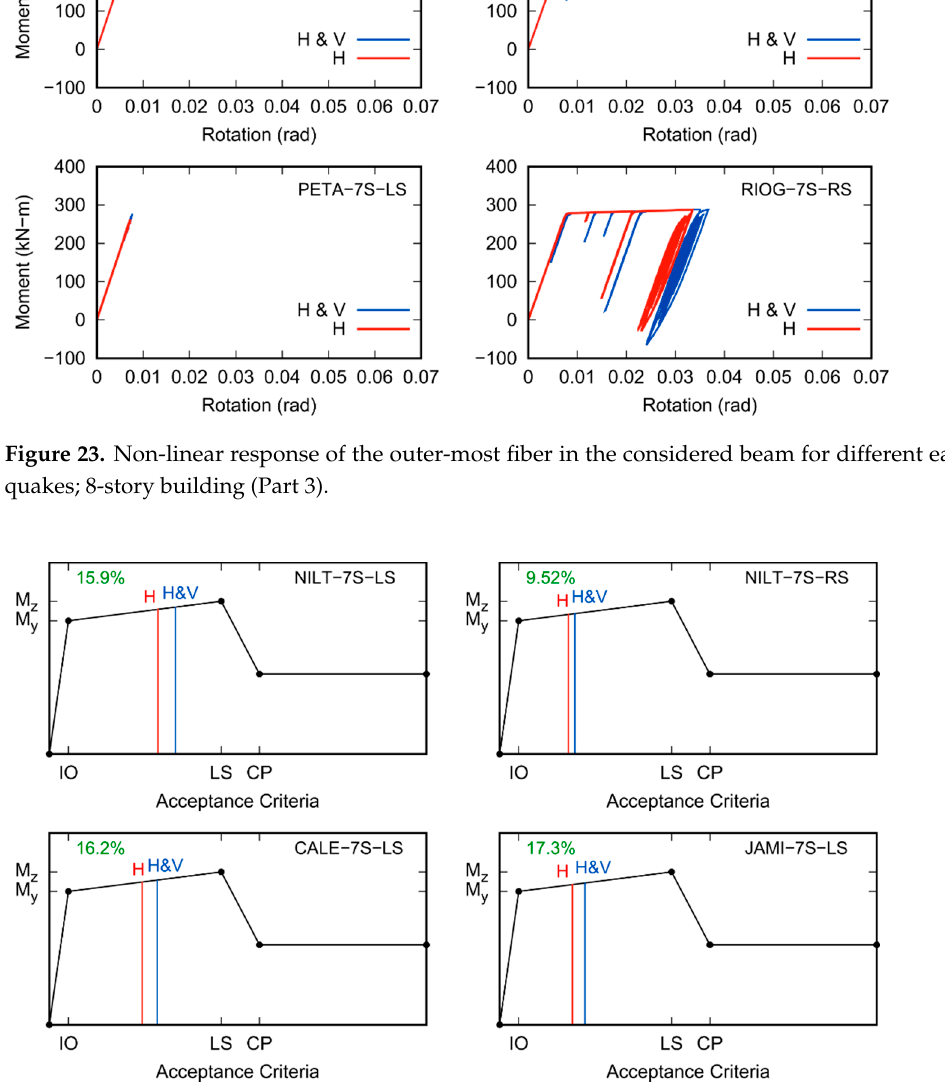
Figure 24. Examples of acceptance criteria for the 8-story building. Part 1.